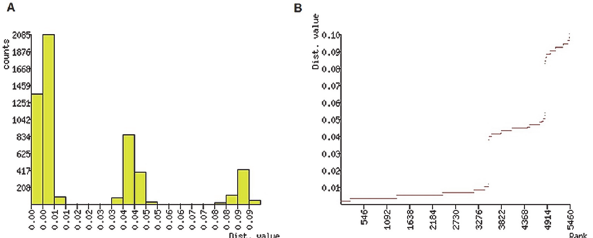
Fig 3. ABGD analysis- Distribution of Maruca spp. population K2P mean divergence in (A) histogram of distances, and (B) ranked distances.